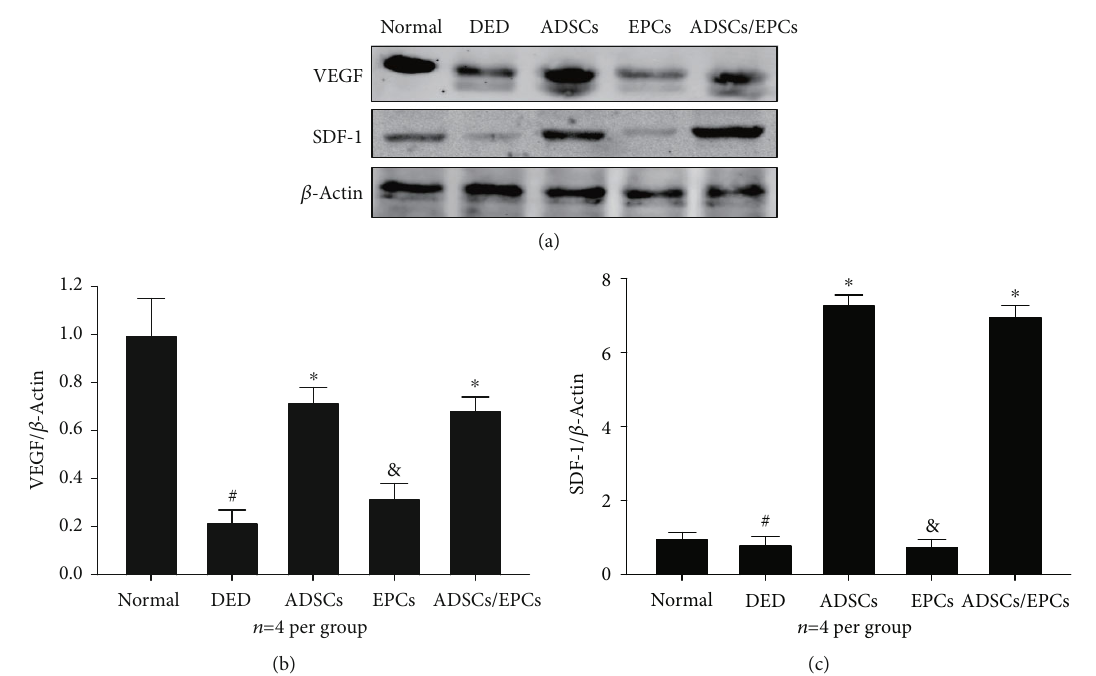
Figure 5: (a, b) The representative images of western blot of VEGF and SDF-1 in the cavernous tissue. (b, c) Quantitative analysis of western blotting, including VEGF and SDF-1. Data is expressed as relative expression compared to β -actin and to the normal group. #: compared with normal control, p < 0 : 05 ; ∗ compared with the DED group, p < 0 : 05 ; &:compared with the DED group, p > 0 : 05 . VEGF: vascular endothelial growth factor; SDF-1: stromal cell-derived factor-1.